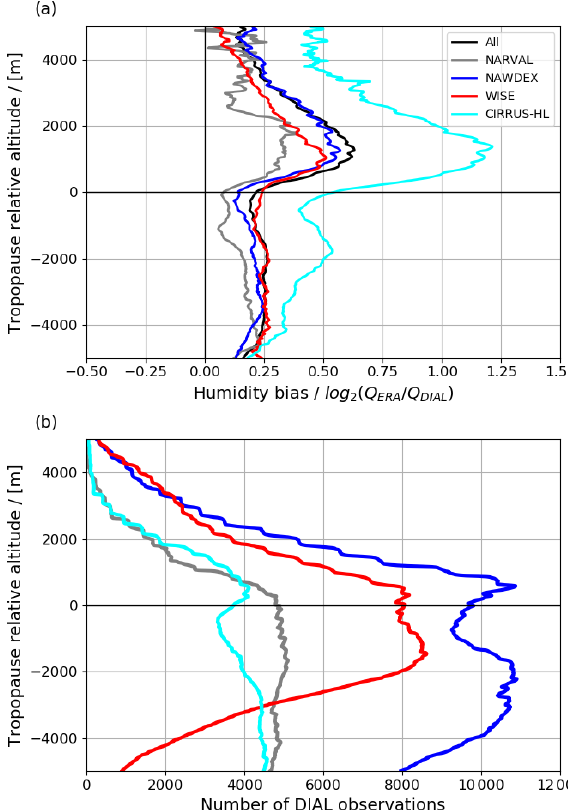
Figure 9. Tropopause-relative profiles of the (a) humidity bias and (b) number of observations for different intervals of tTP altitudes